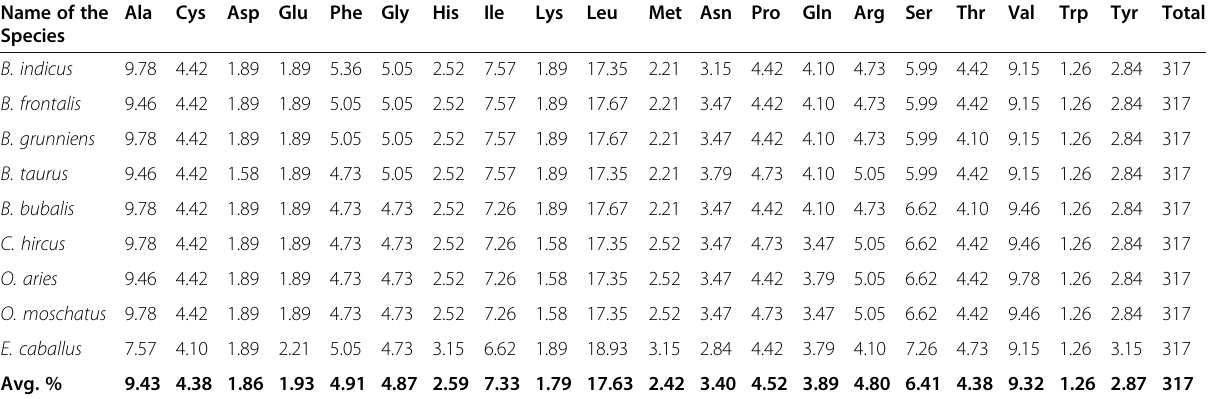
Table 1 MC1R protein amino acid frequency sites used in the mammalian species all frequencies are given in percent (%) Name of the Ala Cys Asp Glu Phe Gly His Ile Lys Leu Met Asn Pro Gln Arg Ser Thr Val Trp Tyr Species